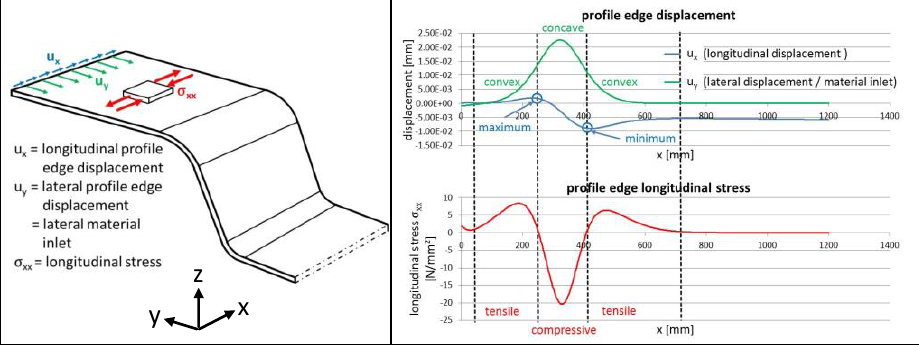
Figure 15. Displacement and longitudinal stresses along the profile edge during the process.